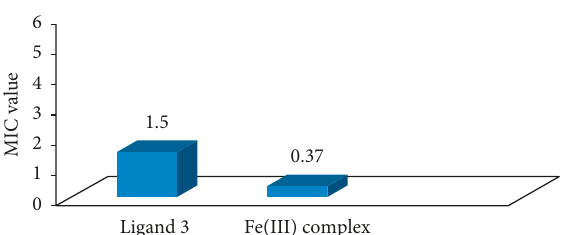
Figure 12: MIC values of ligand 3 (L) and its metal complex against R. stolonifer